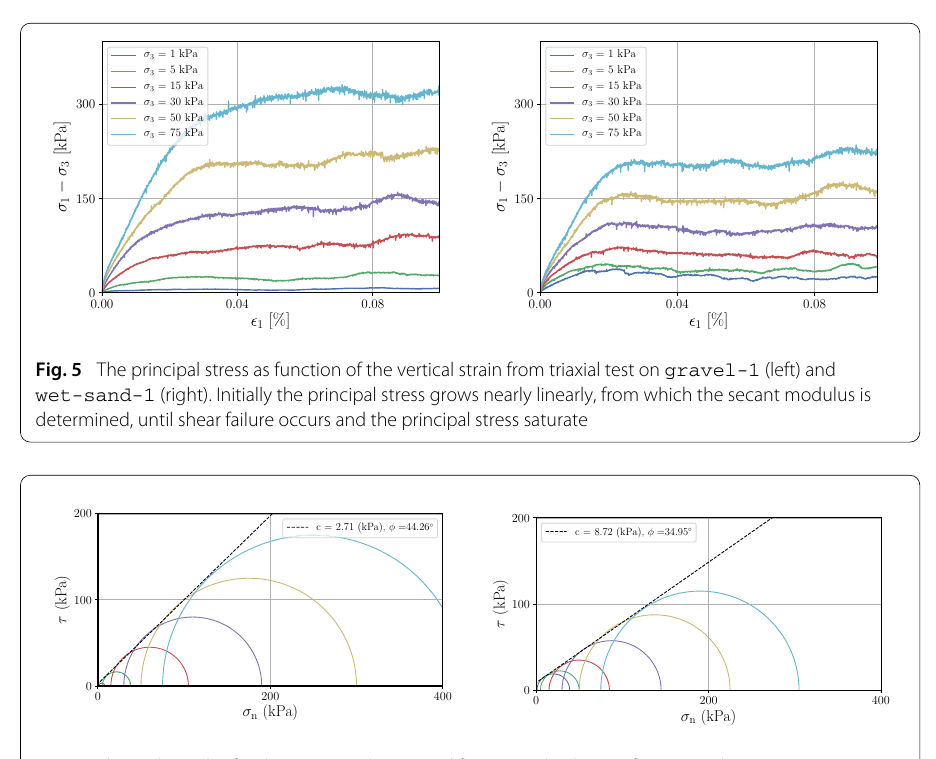
Fig. 7. These bulk parameters are determined for a medium consolidation stress of 15 kPa. The procedure was repeated for all the 15 soils in Table